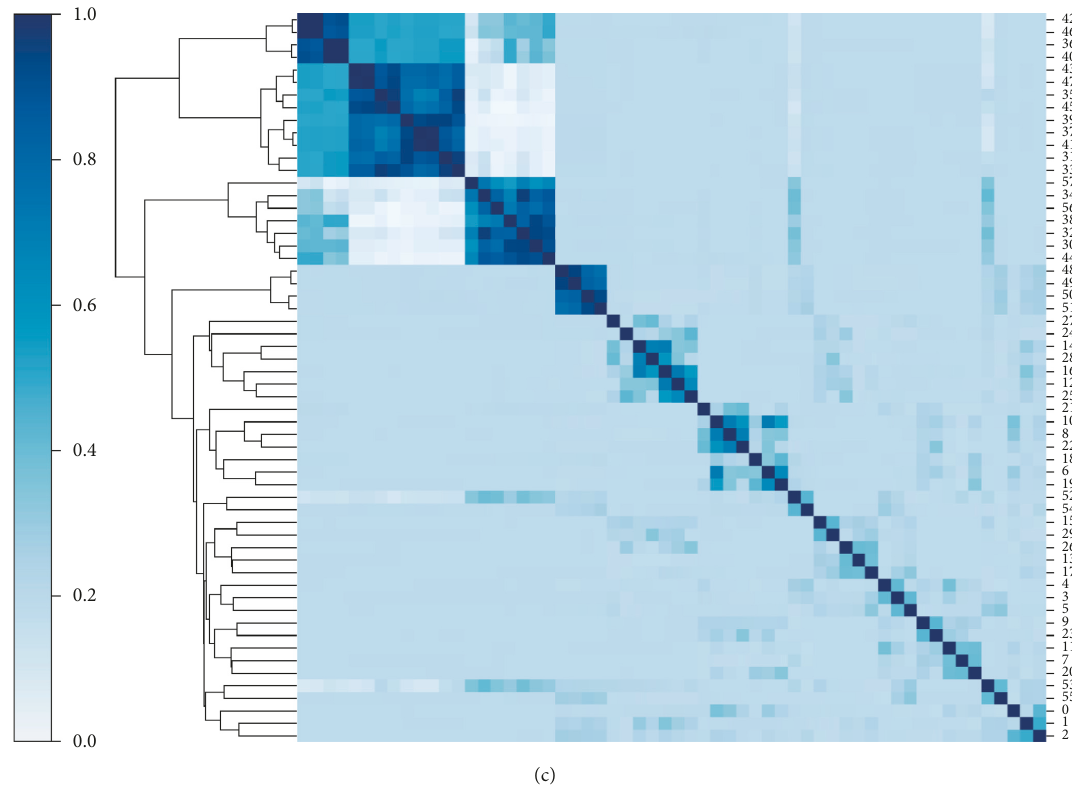
Figure 7: Hierarchically clustered synchrony maps for sensor channels. Hierarchical cluster map based on (a) the amplitude envelope synchrony, (b) the instantaneous phase synchrony, and (c) the composite synchrony. Table 2: The experiment results of bogie fault classification.